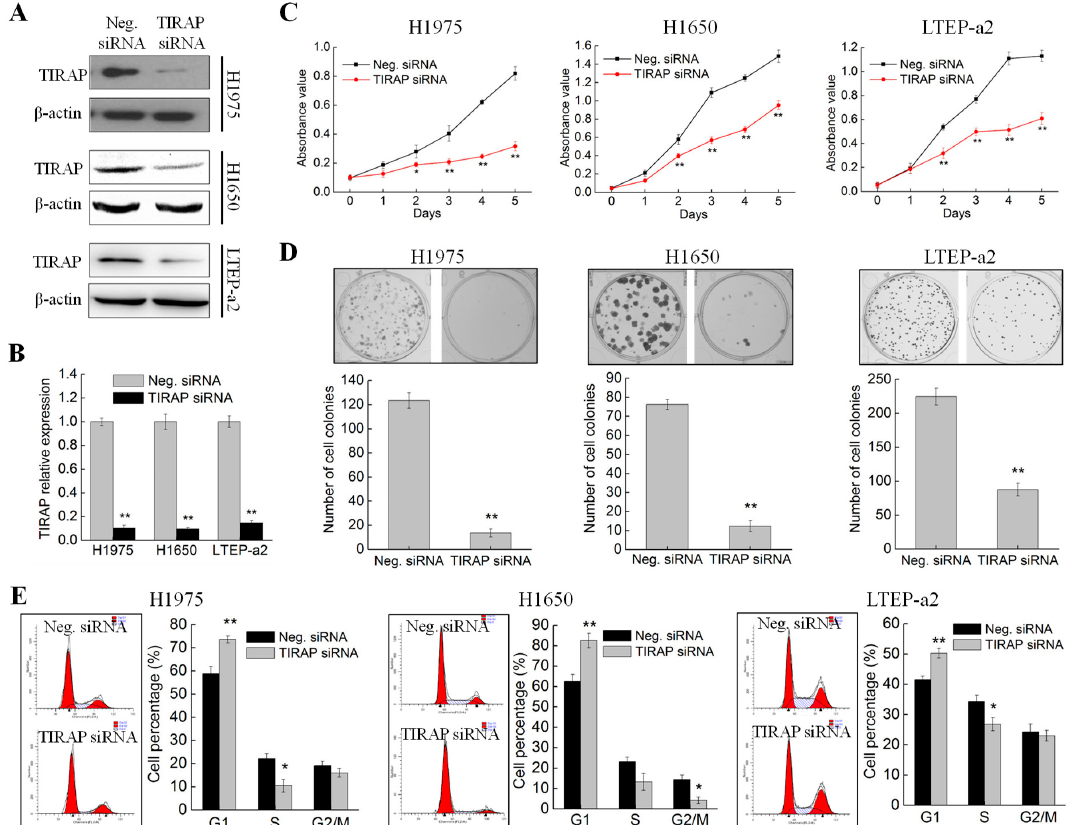
Figure 4. Knockdown of TIRAP expression suppressed the proliferation of non-small cell lung